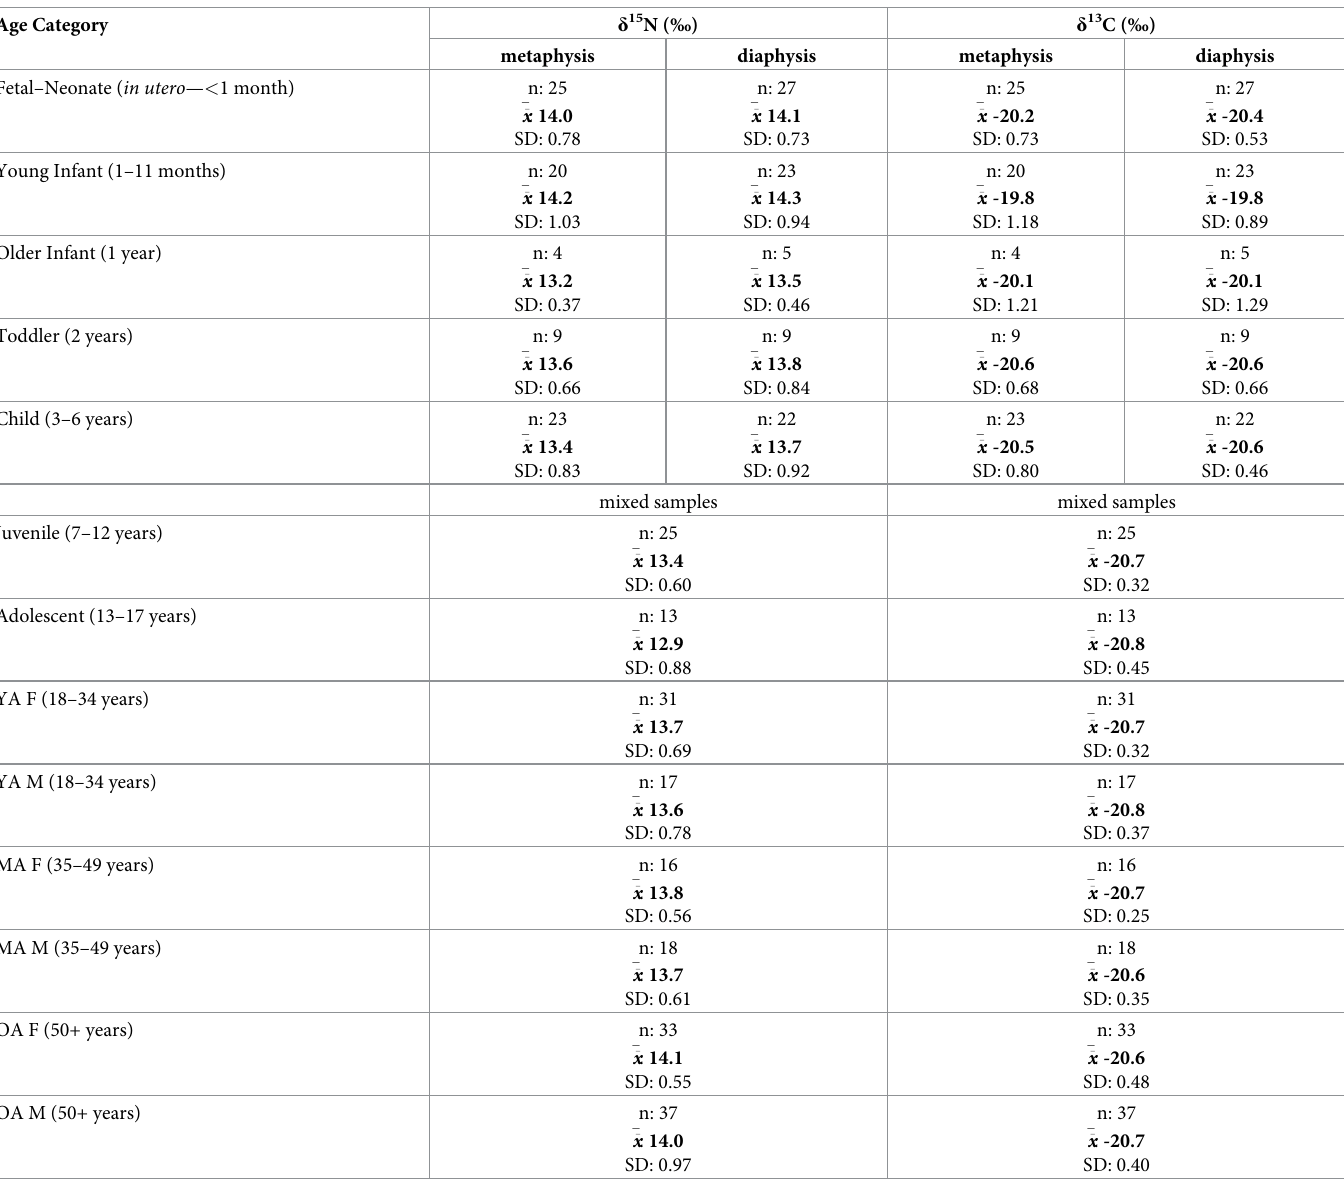
Table 2. δ 15 N and δ 13 C results for the Middenbeemster